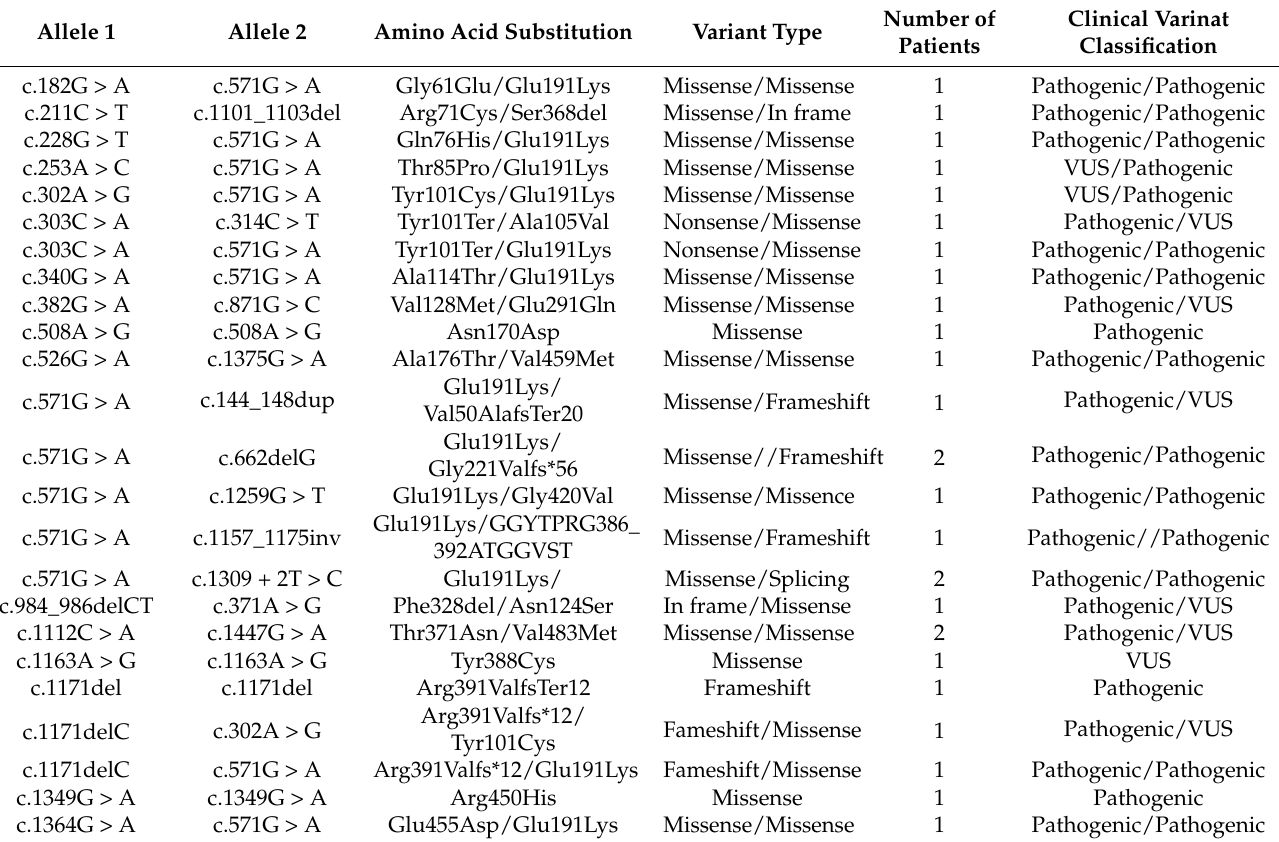
Table 2. Genetic variants of the ALPL gene in 27 compound heterozygotes and homozygotes HPP